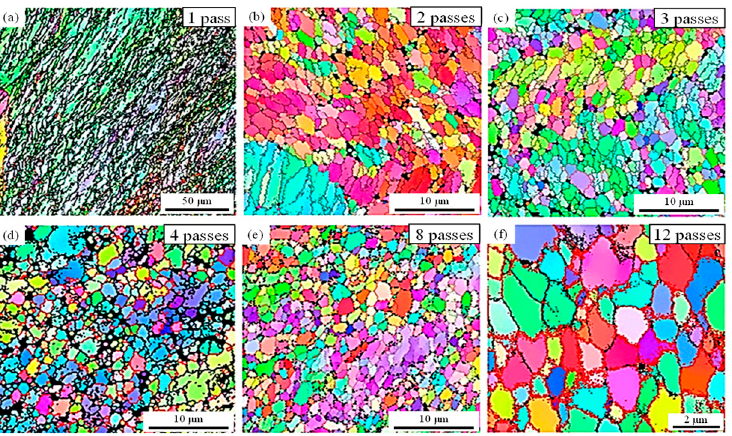
Figure 4. OIM images under different passes [25]: ( a ) one pass; ( b ) two passes; ( c ) three passes; ( d ) four passes; ( e ) eight passes; ( f ) twelve passes. Reproduced with permission from Elsevier B.V.